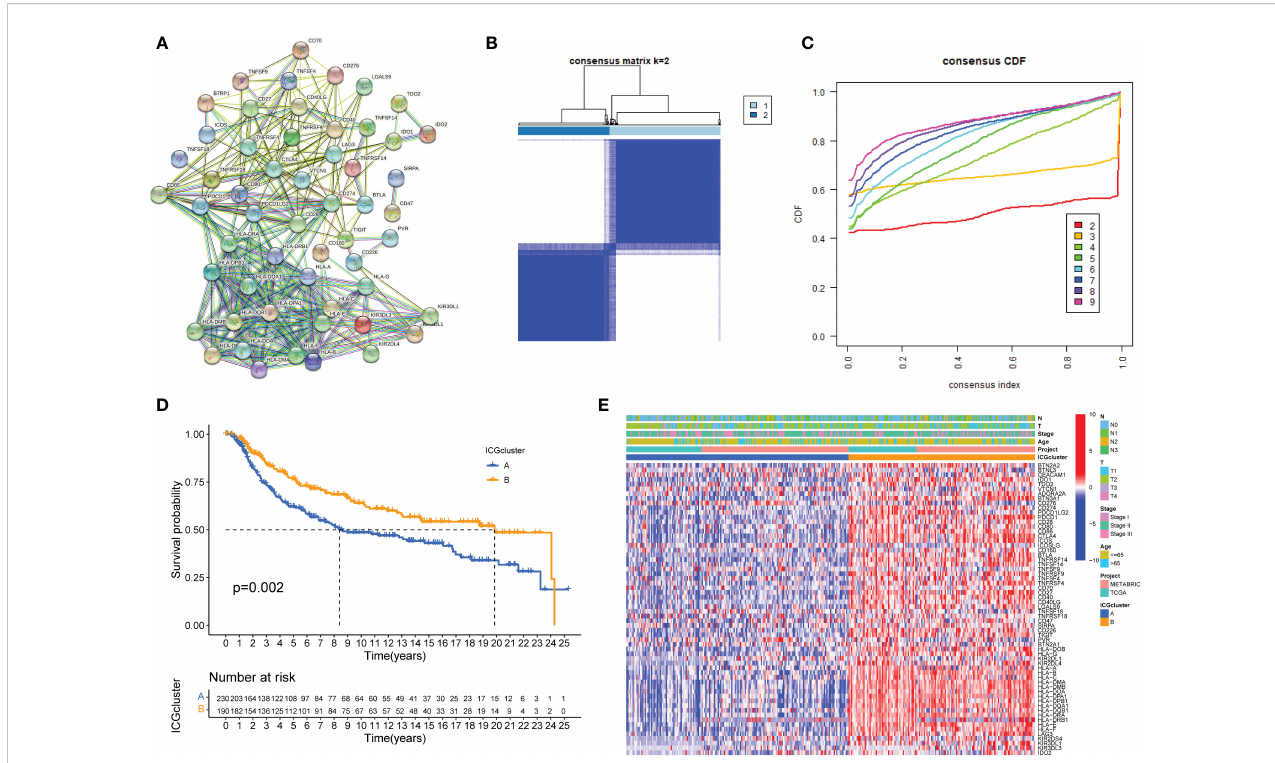
FIGURE 1 ICGs expression patterns in TNBC. (A) Protein interaction network of ICGs by STRING database. (B, C) Consensus clustering matrix for k = 3 based on ICG expression. (D) Kaplan-Meier curves of OS for two TNBC subtypes. The numbers of patients in ICGscluster-A and ICGscluster-B subtypes are 230 and 190, respectively. (E) Unsupervised clustering of ICGs expression to divide TNBC patients into two ICGs subtypes. The ICGclusters, datasets, age, stage and survival status were used as patient